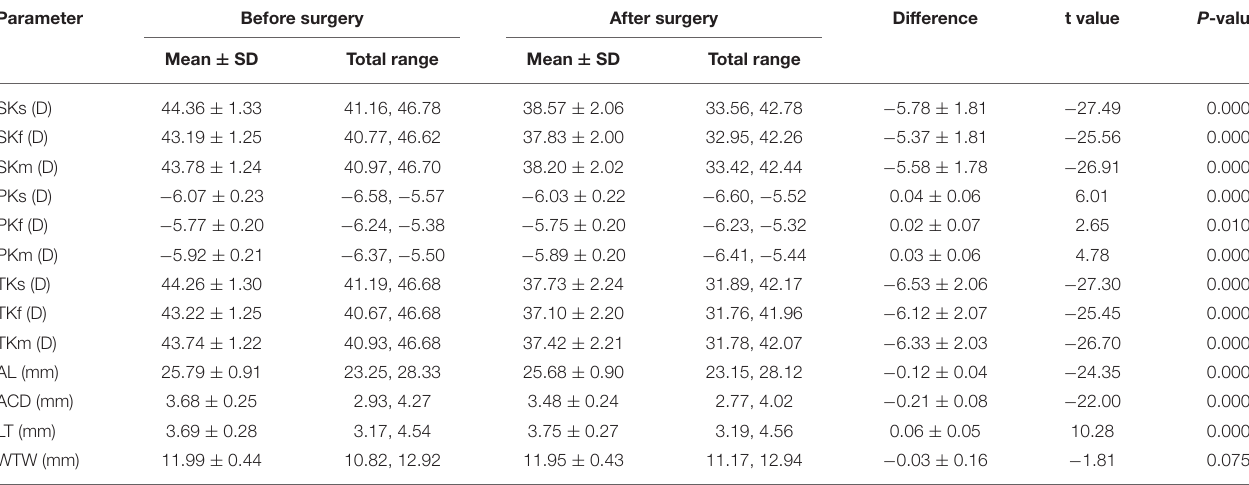
TABLE 1 | Biometric parameters before and after myopic corneal refractive surgery by IOLMaster 700. Parameter Before surgery After surgery Difference t value P -value